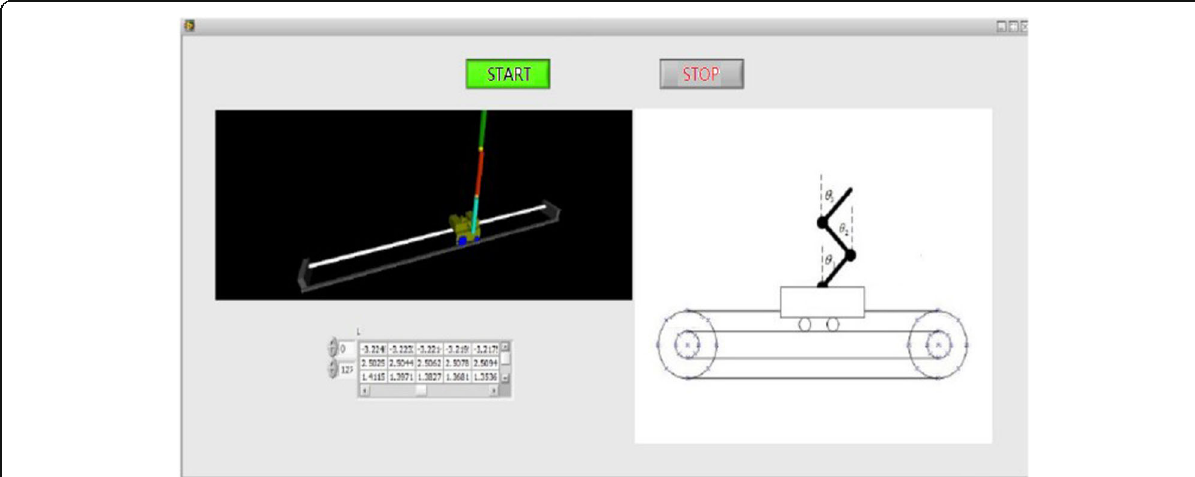
Fig. 2 3D animation simulation results of the control